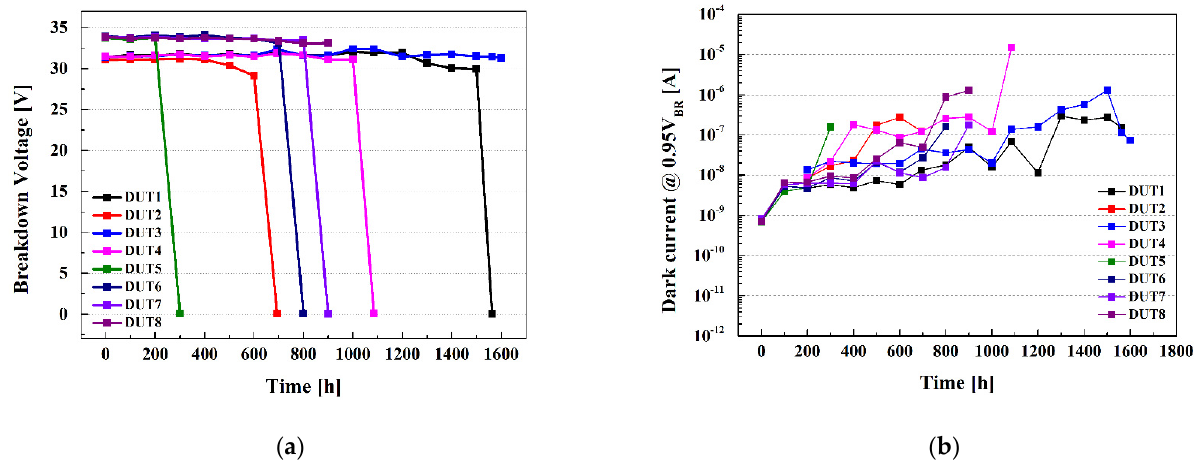
Figure 9. Monitored electrical characteristics of the ( a ) breakdown voltage (V BR ) and ( b ) dark current (I D ) at 473 K and 500 μ A.